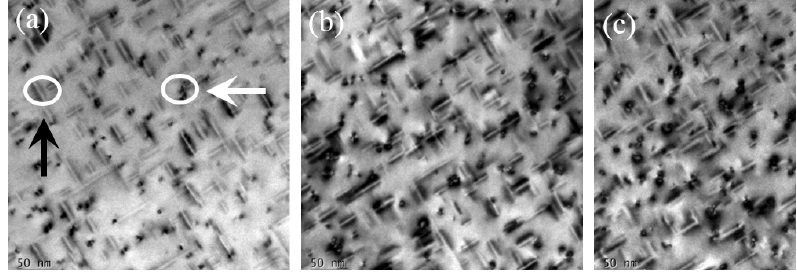
Figure 3. TEM micrographs of the three alloys at peak-ageing conditions: ( a ) alloy A, ( b ) alloy B, and ( c ) alloy C.